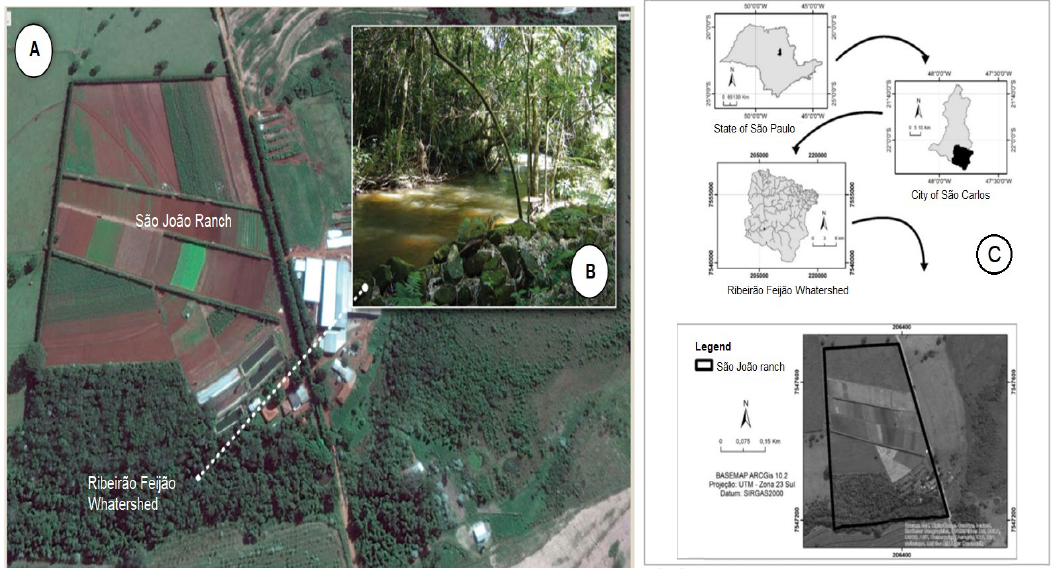
Fig. 4. São João Ranch: (A) Panoramic view of the ranch, (B) Ribeirão Feijão watershed and (C) Location of São João ranch. In this figures (A) and (B) were adapted from Almeida-Neto, et al., (2020) [61] and (C) adapted from Silva et al., (2016),